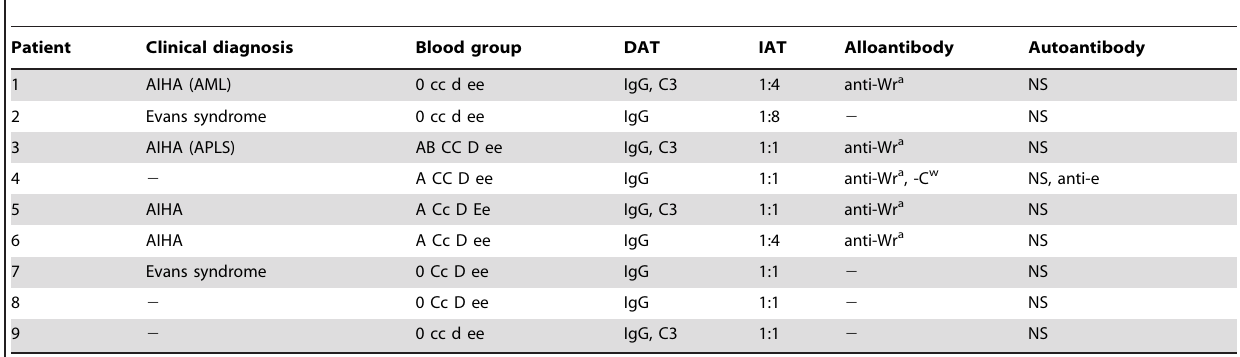
Table 1. Summary of patient